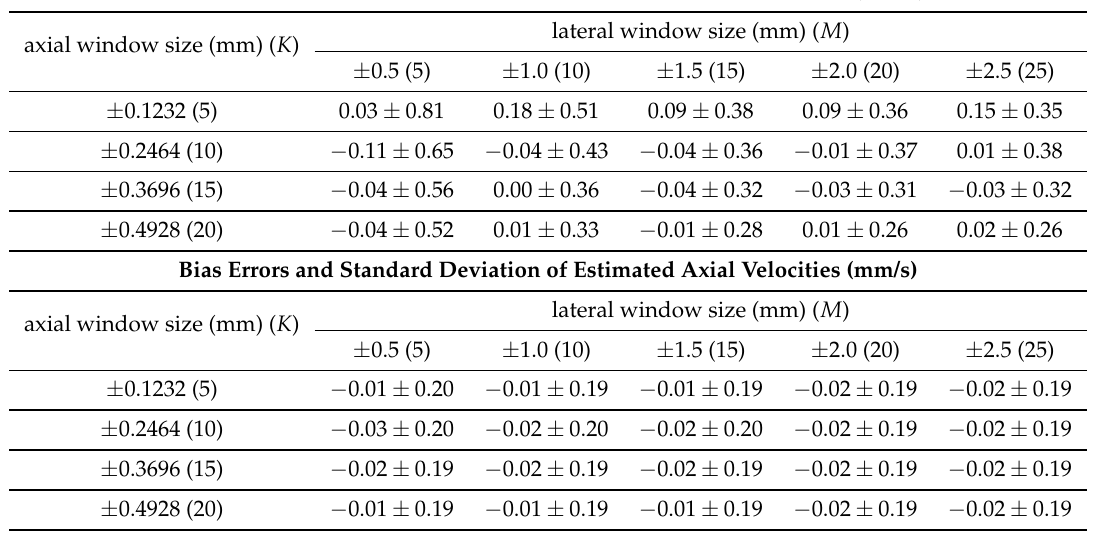
Table 6. Bias errors e bias and standard deviations σ of lateral and axial displacementsat nine red points in Figure 4a estimated by the proposed 2D motion estimator with frame